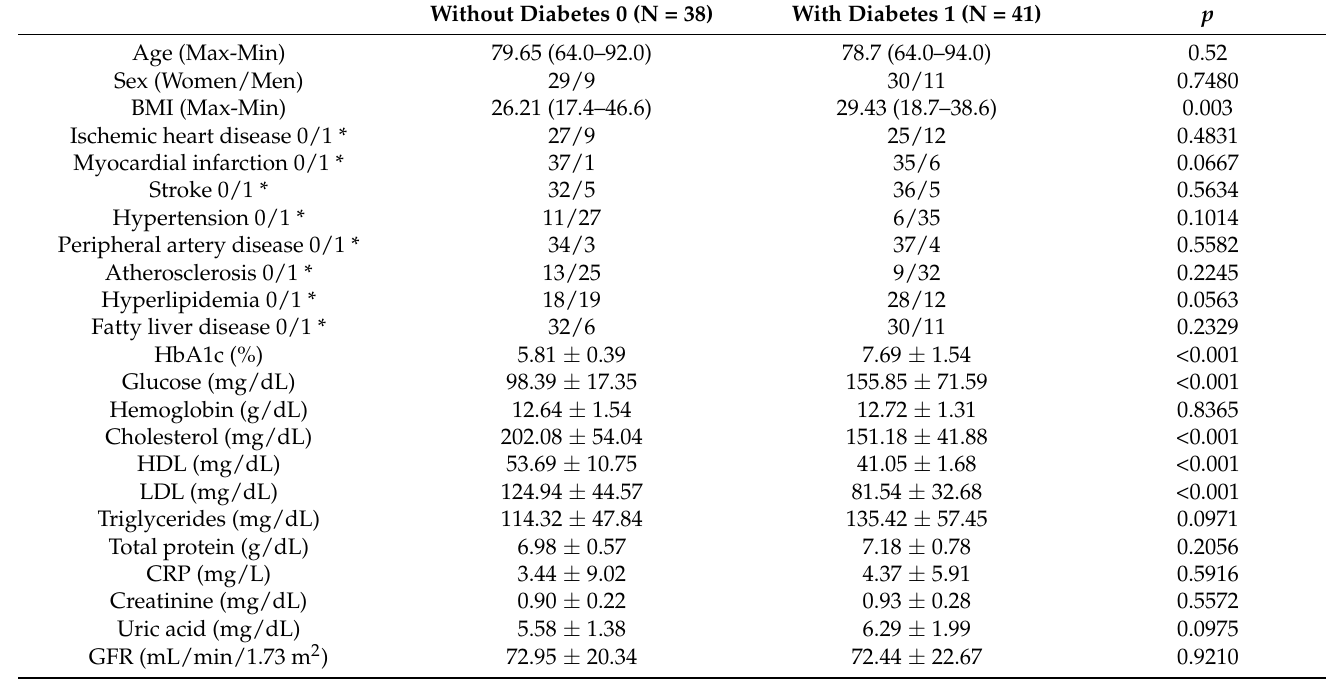
Table 1. Characteristics of the study group. Without Diabetes 0 (N = 38) With Diabetes 1 (N =